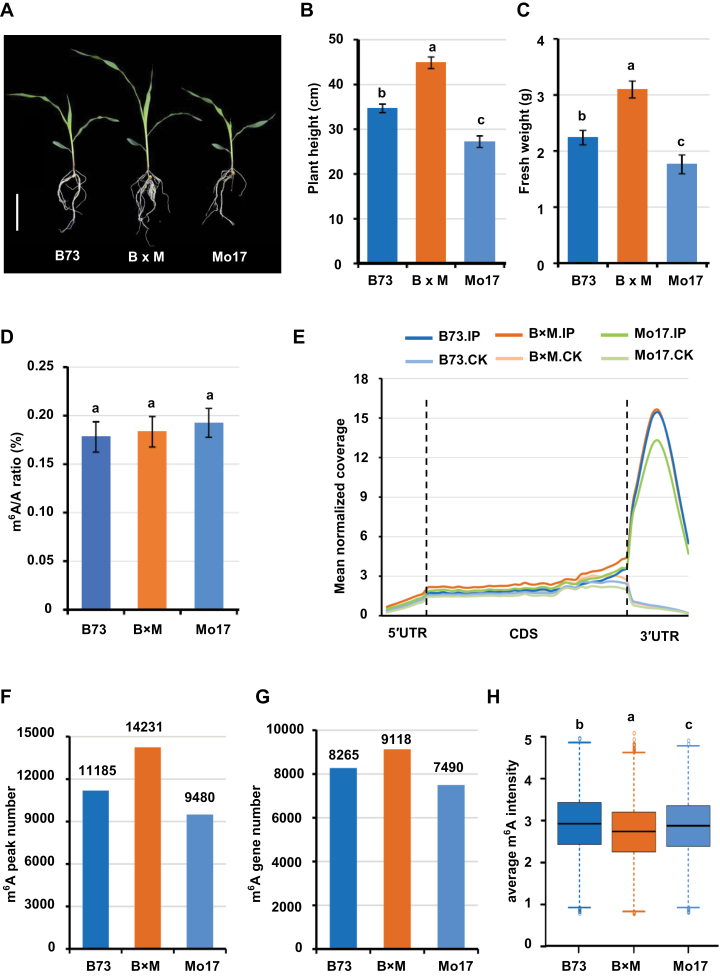
Heterosis of vegetative growth and m6A modification in maize F1 hybrid seedlings at 14 DAS. (A) Heterotic phenotype of the maize hybrid B73×Mo17 relative to the parental lines B73 and Mo17. Bar: 20 cm. (B–H) Comparison between hybrid and parental lines of plant height (B), fresh weight (C), total m6A abundance (D), m6A peak configuration (E), total number of m6A peaks (F), total number of m6A-modified genes (G), and average m6A intensity (H). IP, m6A peaks; CK, negative peaks. Duncan’s analysis was employed to test statistical significance between hybrid and parental lines. Different letters on the graphs indicate significant differences at P<0.05. Error bars indicate the standard deviation with 15 biological replicates in (B, C) and three biological replicates in (D). B×M, the hybrid B73×Mo17; CDS, coding sequence.